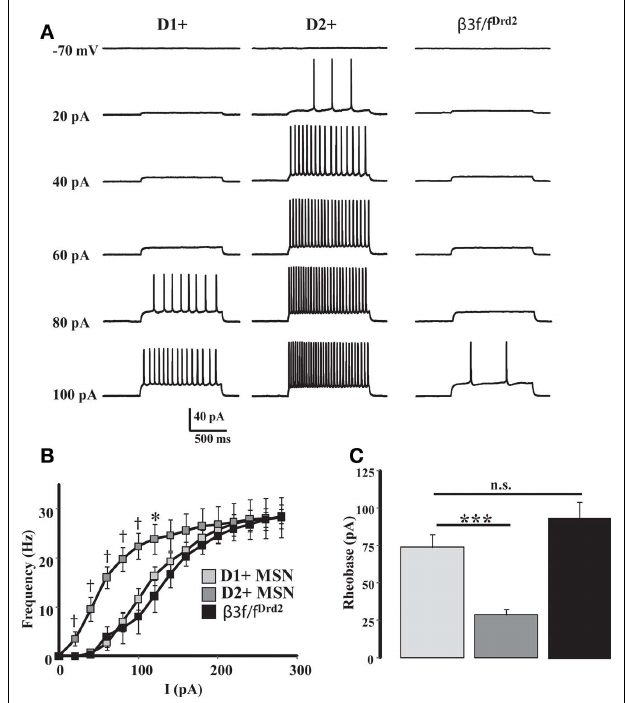
FIGURE 6 | β 3 subunit determines cell excitability. (A) Representative current-clamp recordings from a D1 + MSN (left), D2 + MSN (middle), β 3f/f Drd2 MSN (right), illustrating the responses to a series of depolarizing current injections (20pA steps) from a set potential of − 70mV. (B) Summary of action potential firing frequency in response to increasing depolarizing current injections in D1 + ( n = 10), D2 + ( n = 9), and β 3f/f Drd2 ( n = 10) MSNs. * Denotes p < 0.05 and † denotes p < 0.005 for clarity. (C) Summary graph showing the averaged rheobase current in D1 + , D2 + , and β 3f/f Drd2 MSNs. Data derive from the same cells in (B) , from at least three mice in each